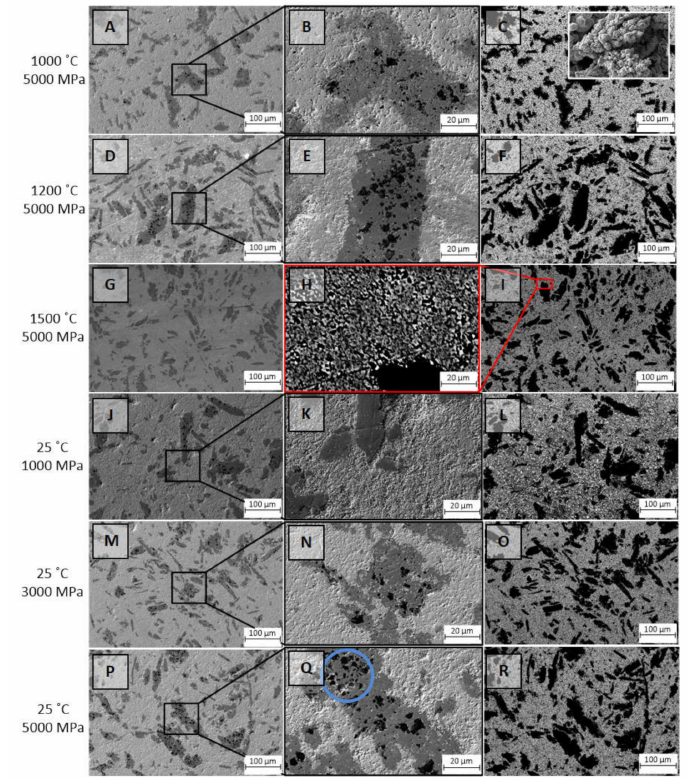
Figure 5. SEM images of the W–Cu composite samples of I type obtained in different sintering conditions and corresponding enlarged images: A – C —Sample 1, D – F —Sample 2, G – I —Sample 3, J – L —Sample 4, M – O —Sample 5, and P – R —Sample 6. Insert: SEM image of the initial copper powder used for the sample